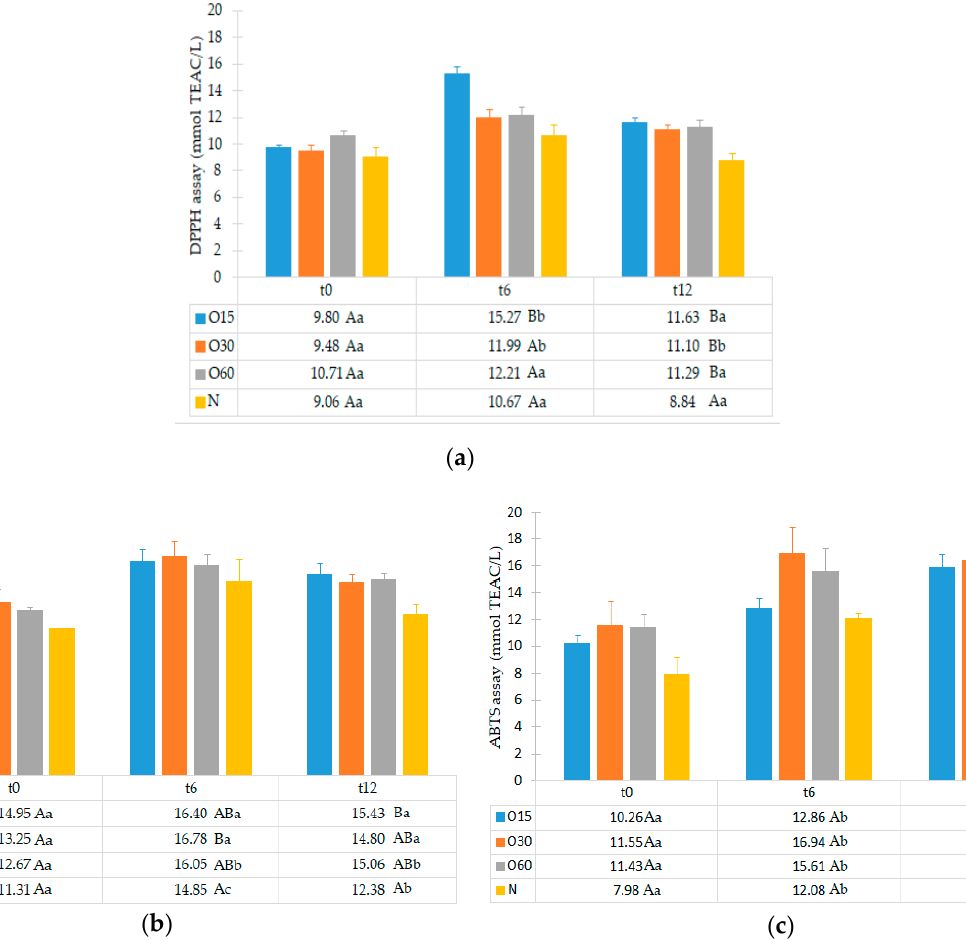
Figure 2. Average values of antioxidant activity of aged WS in each storage time (0, 6, 12 months) according to ageing modalities (O15, O30, O60 and N) using single electron transfer (SET) method: ( a ) DPPH assay; ( b ) FRAP assay; ( c ) ABTS assay. Results are expressed as mean values ± standard deviation ( n = 4). For each analytical determination: different uppercase letters (A, B) in the same column denote significant differences between ageing modalities in each storage time by Tukey’s test ( p < 0.05); different lowercase letters (a, b, c) in the same row denote significant differences between storage times for each ageing modality by Tukey’s test ( p <